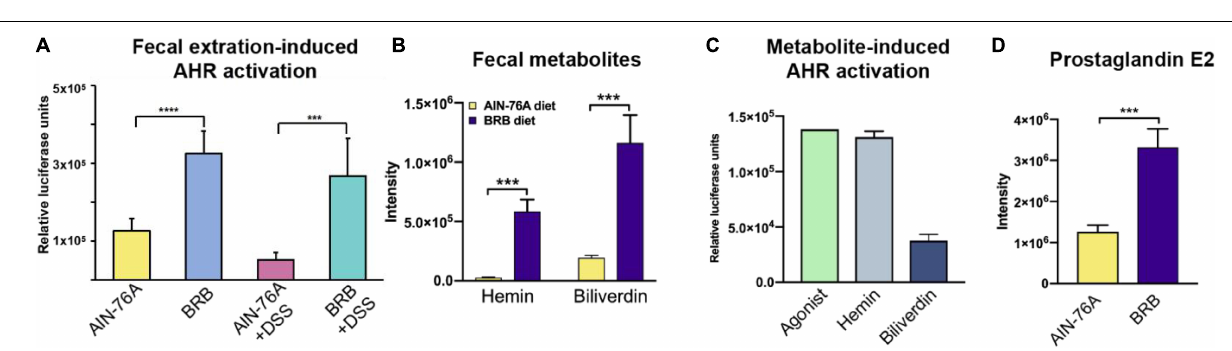
FIGURE 4 | Mice with BRB dietary intervention had increased levels of intestinal AHR activity resulting from higher levels of AHR ligands. (A) Levels of cecal AHR activity of different groups (AIN-76A, BRB, AIN-76A + DSS, BRB + DSS; n = 7; one-way ANOVA followed by Tukey’s test; **** p < 0.0001; *** p < 0.001). (B,C) The levels of AHR agonists, hemin and biliverdin, were significantly higher in the gut microbiome of mice on BRB diet compared to that on control diet ( n = 10; Welch’s two sample t -test; *** p < 0.001). (D) PGE2, product of AHR-activated anti-inflammatory pathway, significantly increased in mice on BRB diet compared to controls. ( n = 10; Welch’s two sample t